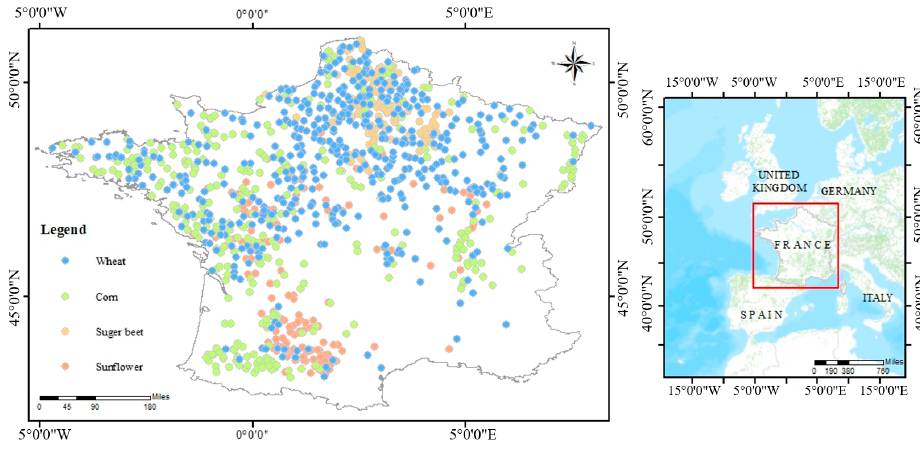
Figure 1. Study region.